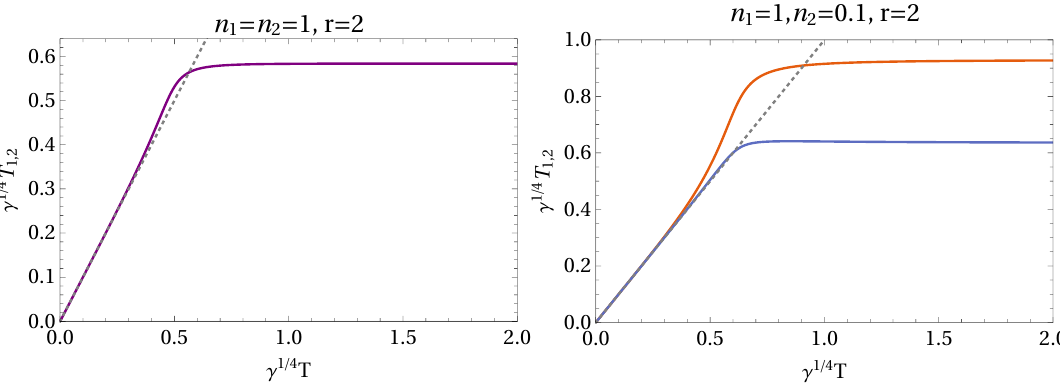
Figure 1 . E(cid:11)ective temperatures of the subsystems as a function of the physical temperature with r = 2 for equal and nonequal ( n 2 = n 1 = 10) subsystems (left and right panel, respectively). As the physical temperature increases, the e(cid:11)ective temperature of the subsystems (cid:12)rst increases in line with the former (the dotted line marks equality), but when T becomes larger than (cid:13) (cid:0) 1 = 4 , the e(cid:11)ective temperatures asymptote to a limiting value. This limiting value is larger for the subsystem with fewer degrees of